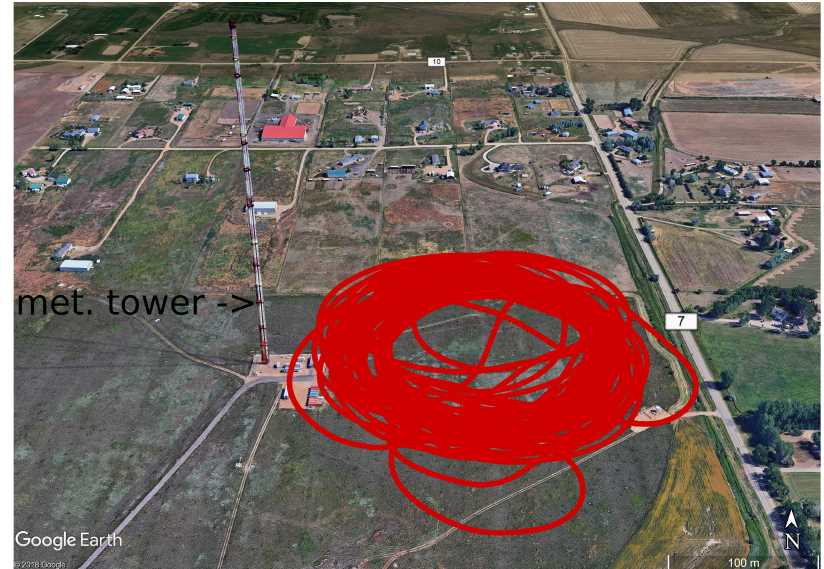
Figure 6. Flight path in red at the Boulder Atmospheric Observatory (BAO) on 8 August 2014 with the meteorological tower in the northwest. During the measurement, low wind speeds from eastern directions with weak convection